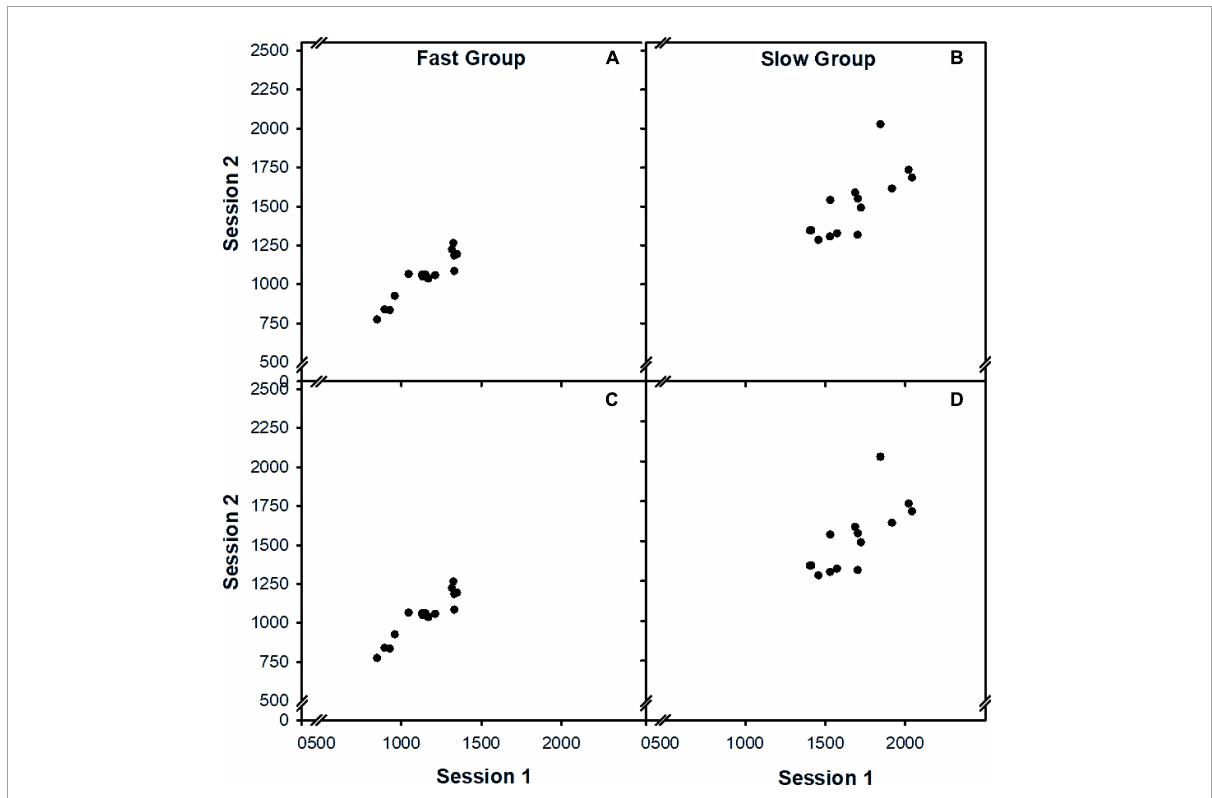
FIGURE3 Results of Experiment 1 and Experiment 2. Scatterplot of the relationship between test and retest performance for both Experiment 1 (Panels A,B ) and 2 (Panels C,D ), separately for a group of fast individual and a group of slow individuals.